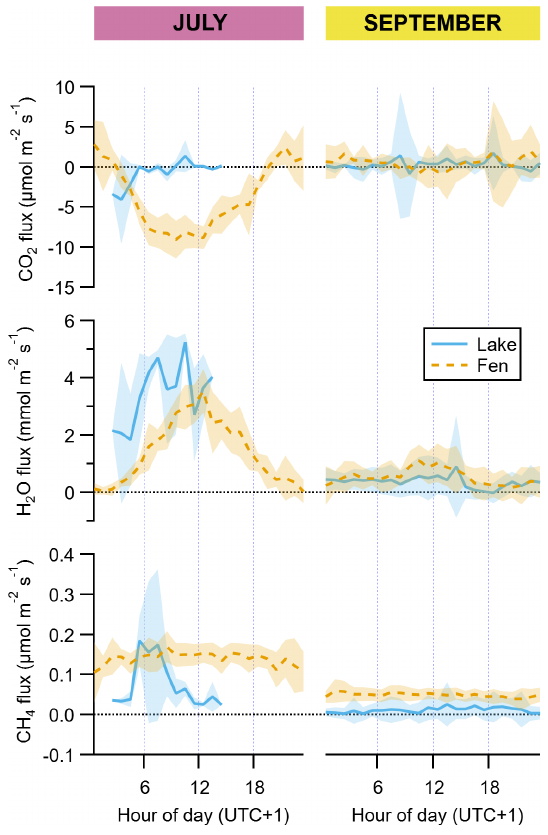
Figure 4. Diel cycles of hourly averages of fluxes of CO 2 , H 2 O, and CH 4 for July and September and for both the lake (solid blue lines) and the fen (dashed orange lines). The peak of the growing season (July) is on the left subpanel of each graph pair, and the post- growing season (September) is on the right subpanel, as indicated on top of the panels. Shaded areas represent ± 1 standard deviation. Each vertical axis has a different scaling, but all of them feature a horizontal dotted line showing where the value zero is